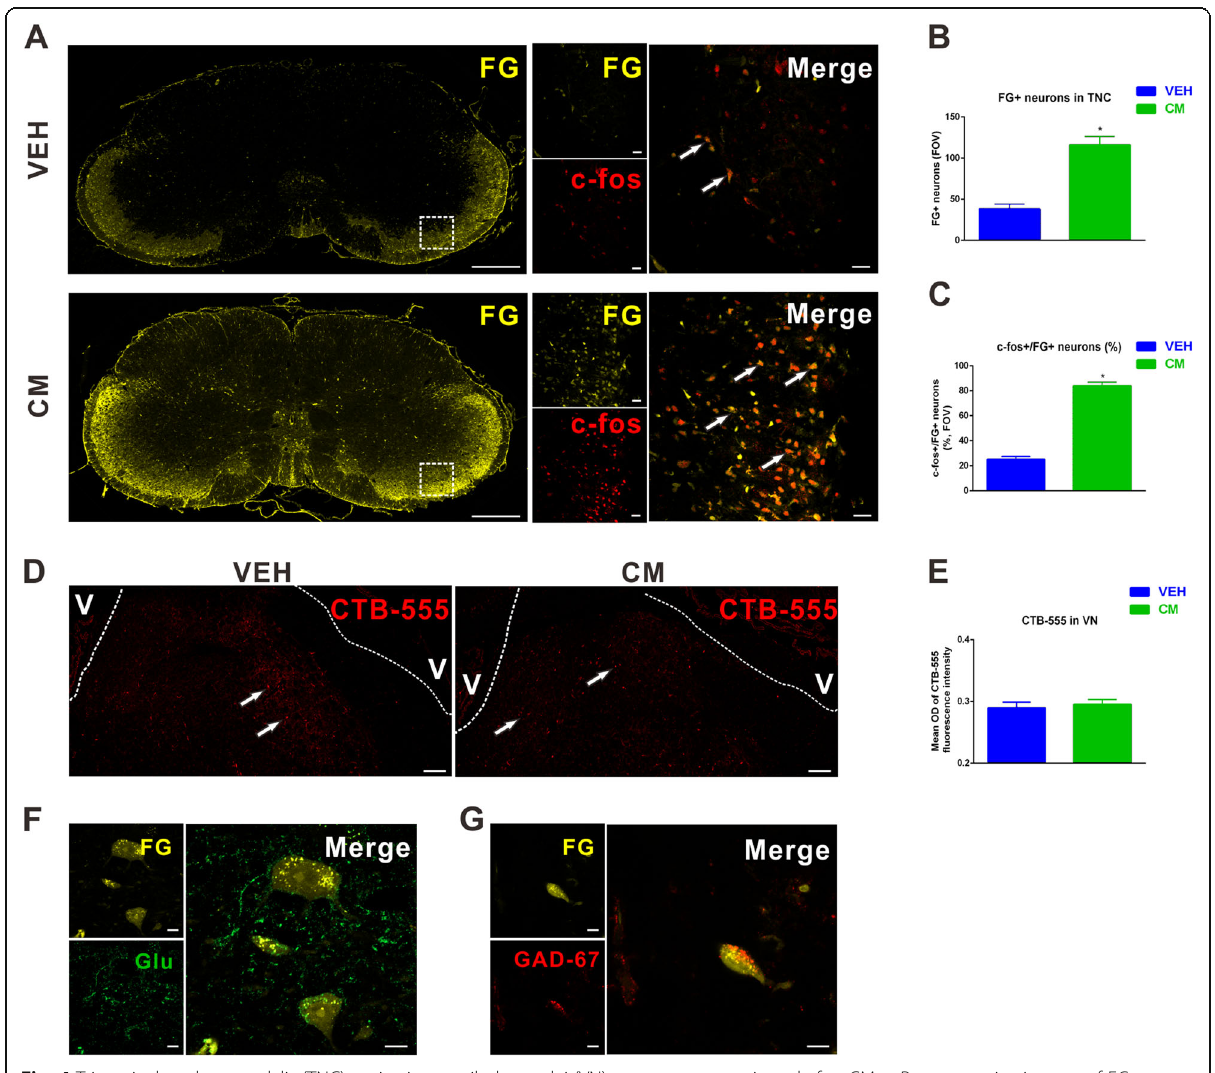
Fig. 4 Trigeminal nucleus caudalis (TNC)-projecting vestibular nuclei (VN) neurons were activated after CM. a Representative images of FG (yellow) co-labeled with c-fos (red) neurons was accumulated predominantly in the superficial layer of the TNC. Quantitative assessments of FG+ neurons ( b ) and c-fos+/FG+ neurons ( c ) were significantly increased in the TNC compared with the vehicle group. FOV = 1.02 × 10 6 μ m 3 . d , e Representative images of immunofluorescence staining and quantification showing the distribution of retrogradely CTB-555 (red) labeled neurons in the VN. f Representative images showing three glutamate (green) immunofluorescent and FG (yellow)-immunolabeled globular, multipolar and fusiform neurons in the TNC projecting to the VN. g Representative images showing a GABA (red) immunofluorescent and FG (yellow)- immunolabeled elliptical neuron in the TNC projecting to the VN. ( a : left row) Scale bar = 1 mm, ( a : right row) Scale bar = 50 μ m, d Scale bar = 100 μ m, f , g Scale bar = 5 μ m; * P < 0.05 compared with vehicle, n = 8/group. Data are mean ± SEM. Student ’ s t -test. V: